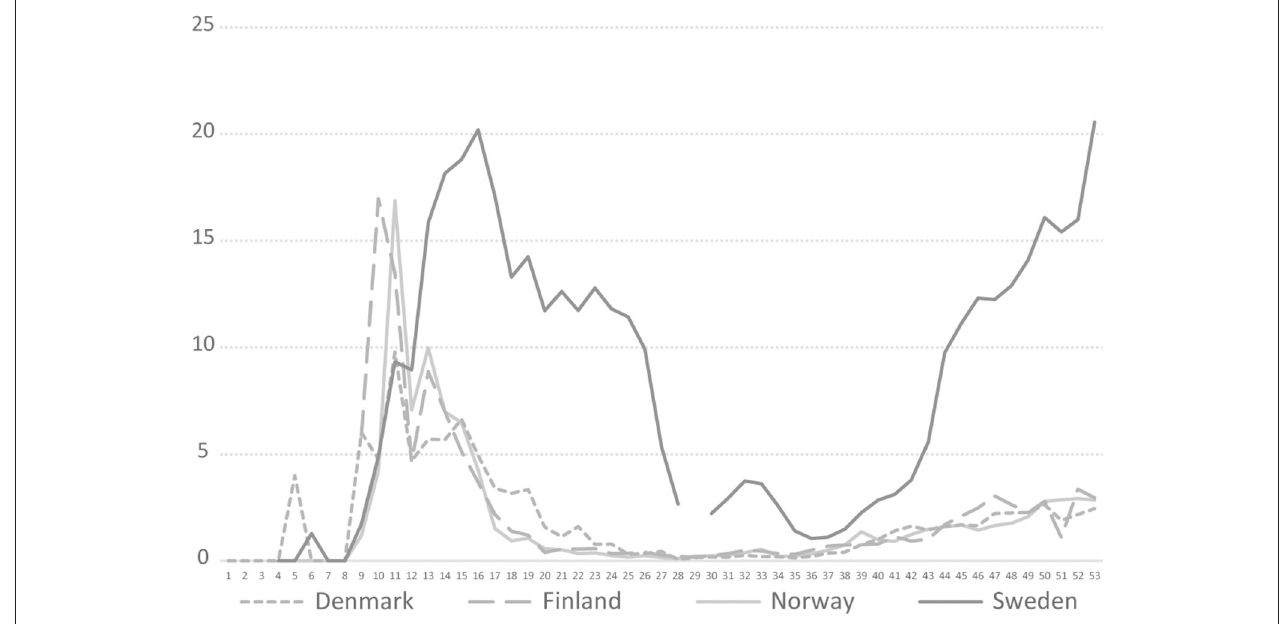
FIGURE 2 | COVID-19 testing positivity rate in four Nordic countries during 2020, Weeks 1–53, 2020. https://www.ecdc.europa.eu/en/publications-data/COVID-19- testing.